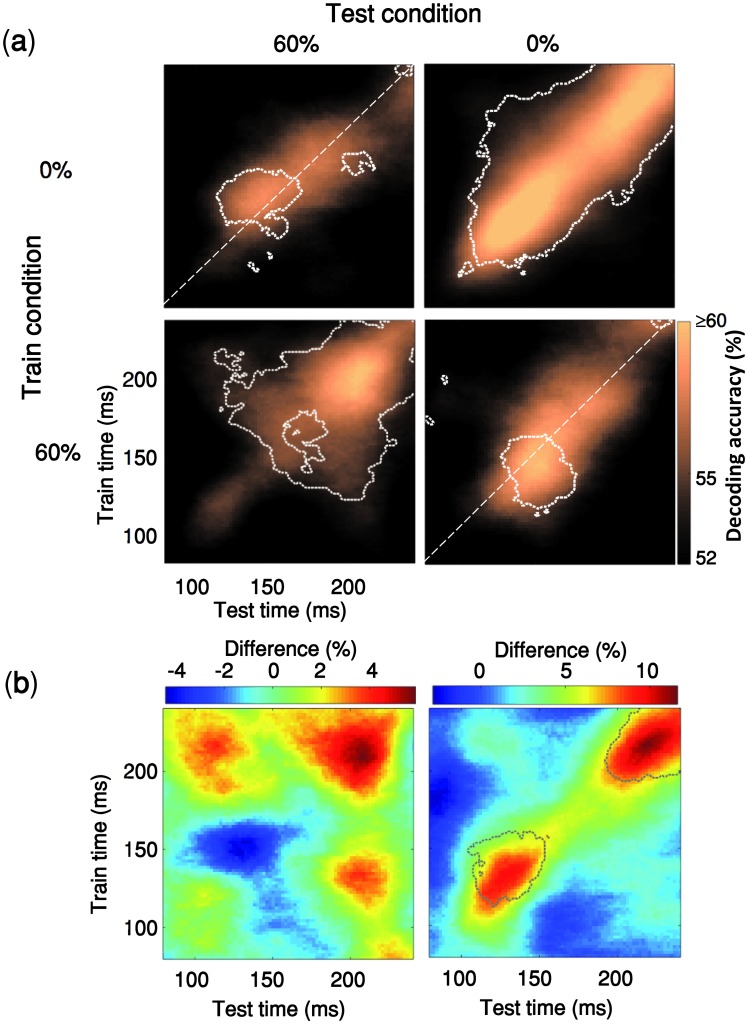
Generalization across time and occlusion levels.(a) The classifier is trained on an occlusion level (e.g. 0% occlusion) and tested on the other occlusion level (e.g. 60% occlusion). Time-points with significant decoding accuracy are shown inside the dashed contours (right-sided signrank test, FDR-corrected across time, p<0.05). The contour of significant time-points has a shift towards the upper side of the diagonal when the classifier is trained with 0% occlusion and tested on 60% occlusion (i.e. 63% of significant time points are above the diagonal) whereas in the lower right matrix we see the opposite pattern (66% of significant time points are located below the diagonal). (b) The two color maps below the decoding matrices show the difference between the two decoding matrices located above them.